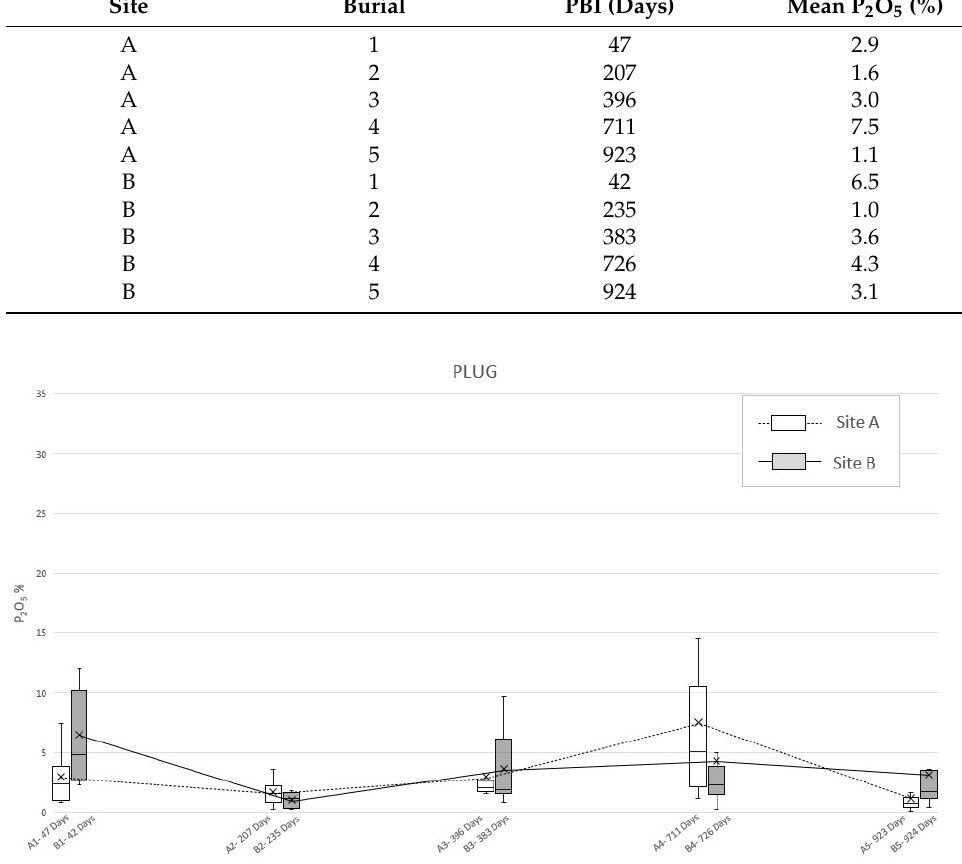
Figure 4. Mean phosphate concentration (P 2 O 5 ) detected in “plug” soil specimens sampled from site A and B at different PBI. The box plots show the minimum value, the maximum value, the sample median, and the first and third quartiles. Data obtained from SEM ‐ EDS analysis. Table 3. Summary of the mean phosphate concentration (P 2 O 5 ) found in each “plug” sample from site A and B at different Post Burial Intervals (PBIs) obtained using SEM ‐ EDS analysis.